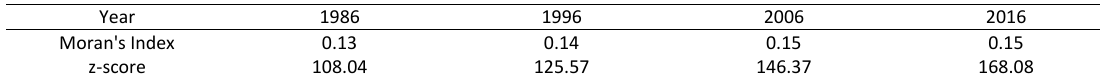
Table 4: Moran’s Index results of Mashhad